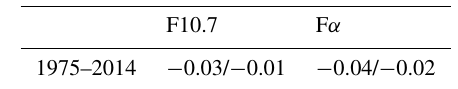
Table 4. Trends (MHz/decade) of fo E calculated from Eq. (2), for Juliusruh and Chilton (values separated with a slash).